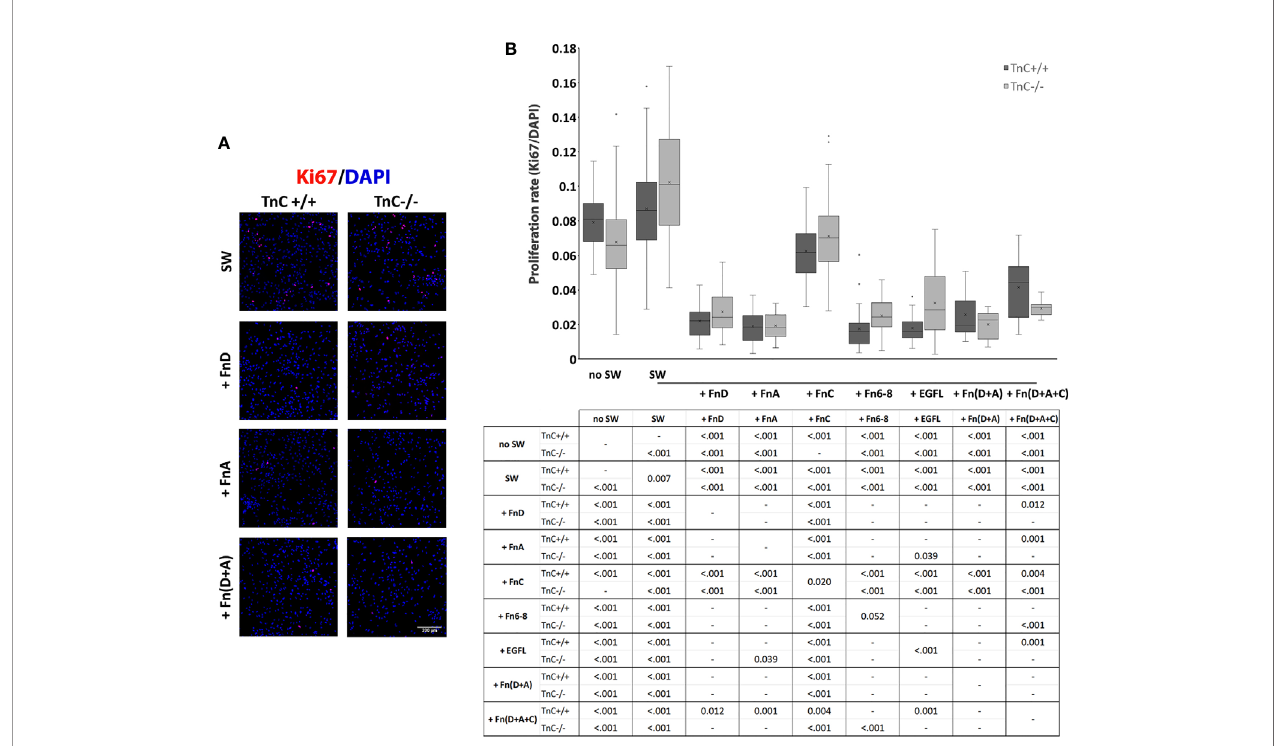
FIGURE 2 | TnC fragments reduce proliferation in the astrocyte scratch wound assay. (A) Representative micrographs of Ki67+/DAPI+ immuno fl uorescence at 24 h after scratching in the control group and groups treated with FnA, FnD, and Fn(D+A); bar: 200 m m. (B) Proliferation was calculated as the number of Ki67+ nuclei compared to total DAPI+ nuclei. Results are presented as a box-and-whisker plot. Two-way ANOVA analysis shows a statistically signi fi cant interaction between the effects of genotype and treatment on cell proliferation rate ( p = 0.005) with both the effects of genotype and treatment being signi fi cant ( p = 0.040, p < 0.001, respectively). A statistically signi fi cant decrease in proliferation is seen in the presence of FnA, FnD, and Fn(D+A). All statistically signi fi cant pairwise comparisons are displayed below the box-and-whisker plot. n = 3 independent astrocyte